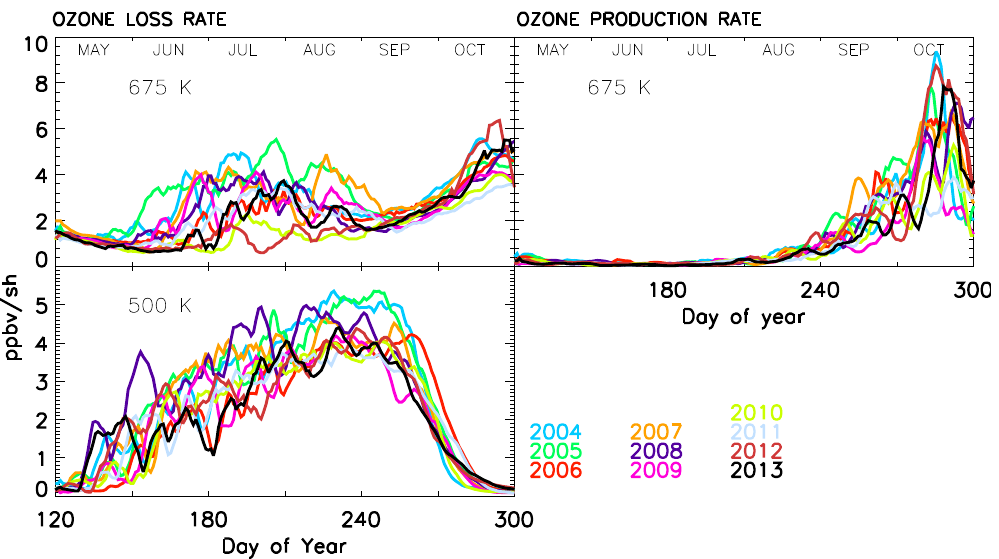
Figure 7. Vortex-averaged (defined by ≥ 65 ◦ EqL) chemical ozone loss and production rates at 675K ( ∼ 26km) and 500K ( ∼ 19km) in ppbv per sunlit hour (ppbvsh − 1 ) for the Antarctic winters 2004–2013 estimated from the MIMOSA–CHIM model